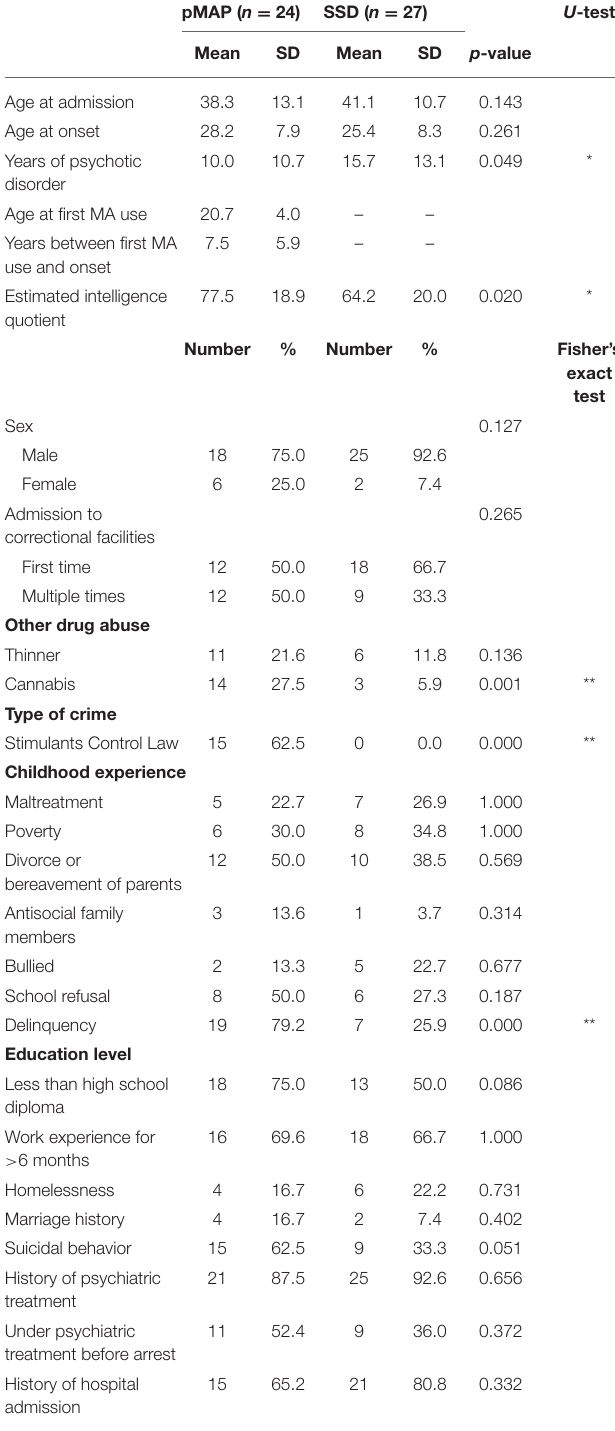
TABLE 1 | Background characteristics of pMAP and SSD patients in the medical